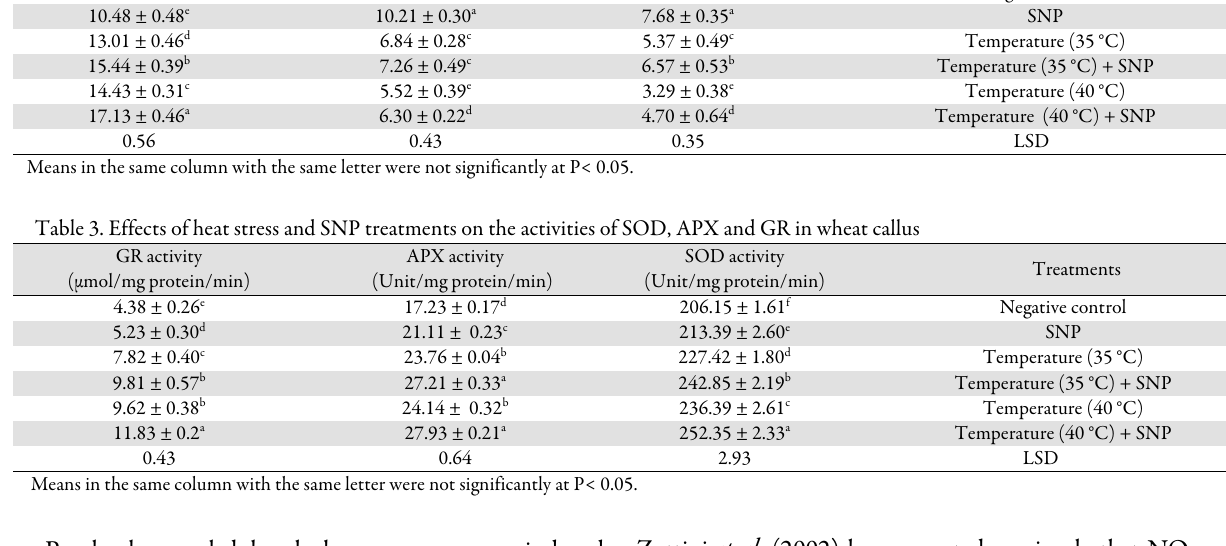
Means in the same column with the same letter were not significantly at P < 0.05. Table 2. Effects of heat stress and SNP treatments on the content of reduced glutathione, total ascorbic acid and total soluble sugars in wheat callus Total soluble sugars (mg/g FW)